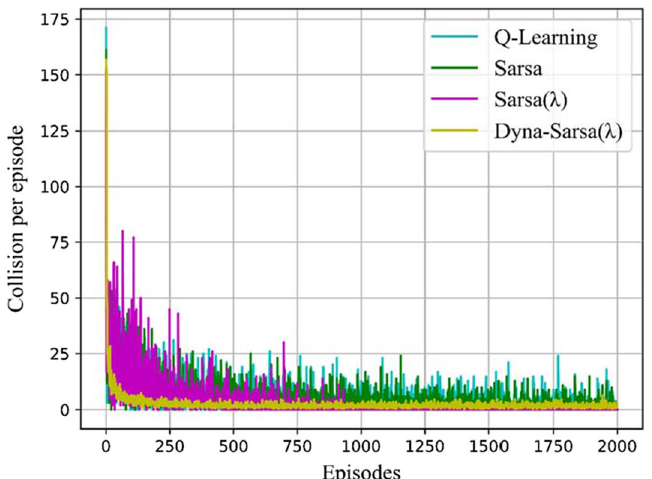
Fig. 10 Comparison of the number of ship collisions in each iteration. The performance comparison of the number of ship collisions between the proposed model and baselines in each